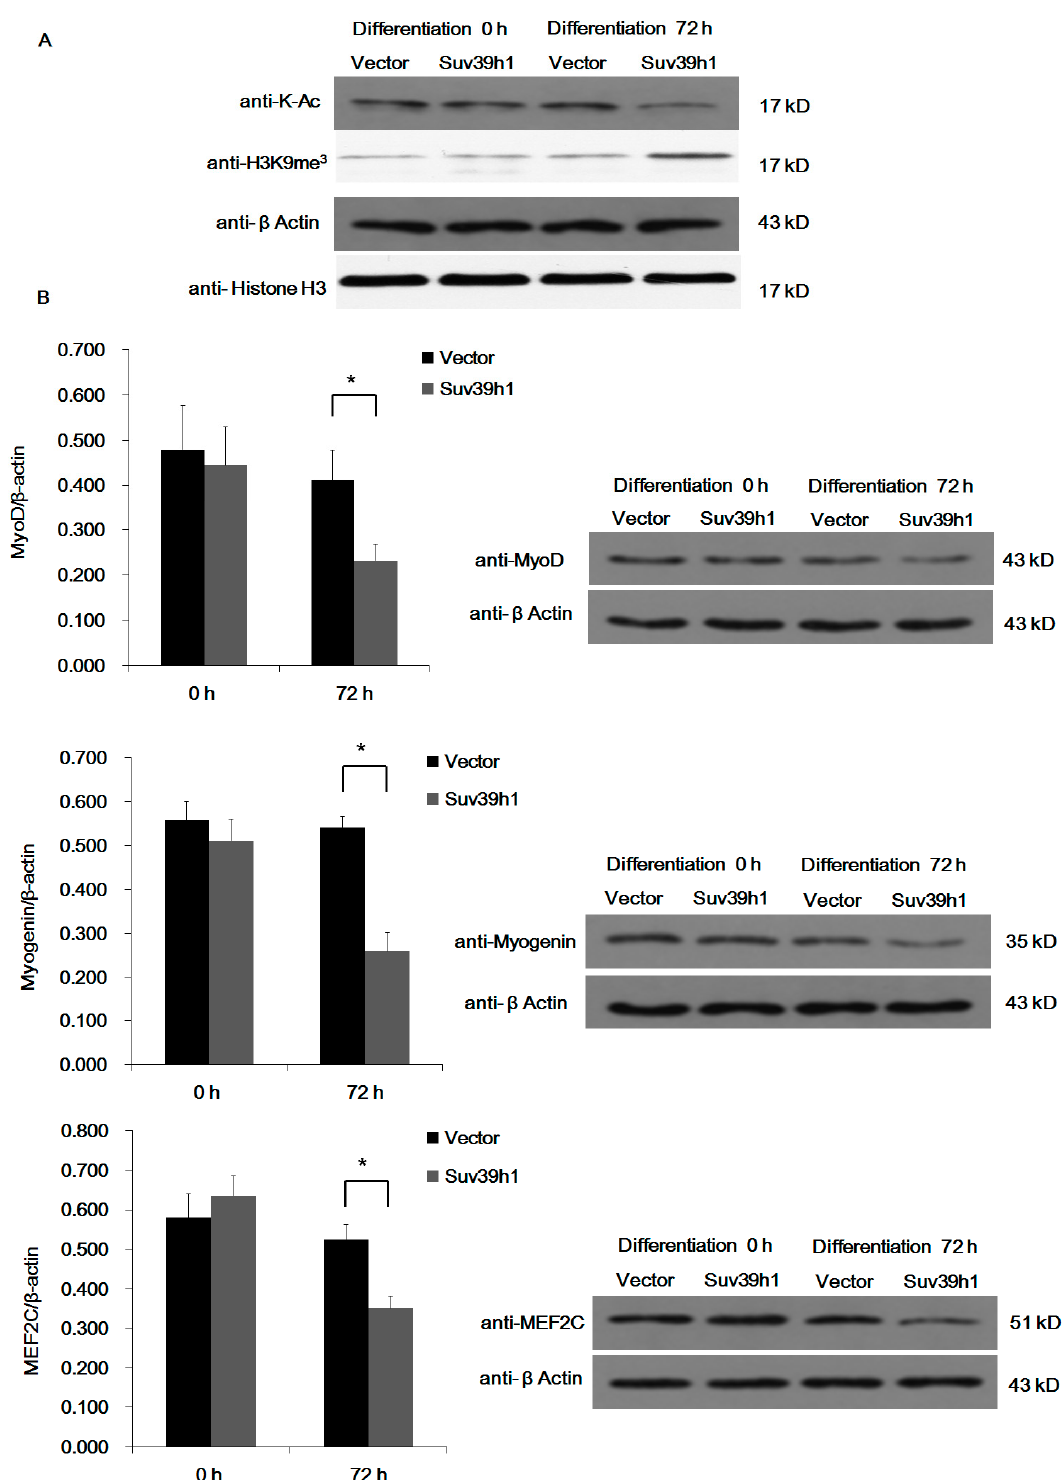
Figure 3. Suv39h1 inhibited skeletal muscle differentiation. C2C12 cells were transfected with pIRES-Suv39h1 or empty vector as a control. Cells were transferred to differentiation medium for the indicated time, and levels of histone modifications ( A ); and myogenic differentiation proteins ( B ) were analyzed by Western blot analysis. β -actin and histone H3 were used as a loading control. The quantification on Western blot of indicated proteins were normalized to β -actin. Bars represented the mean ± SD of three experiments. The statistical significance of the differences values was analyzed by Student’s t -test, * p < 0.05.